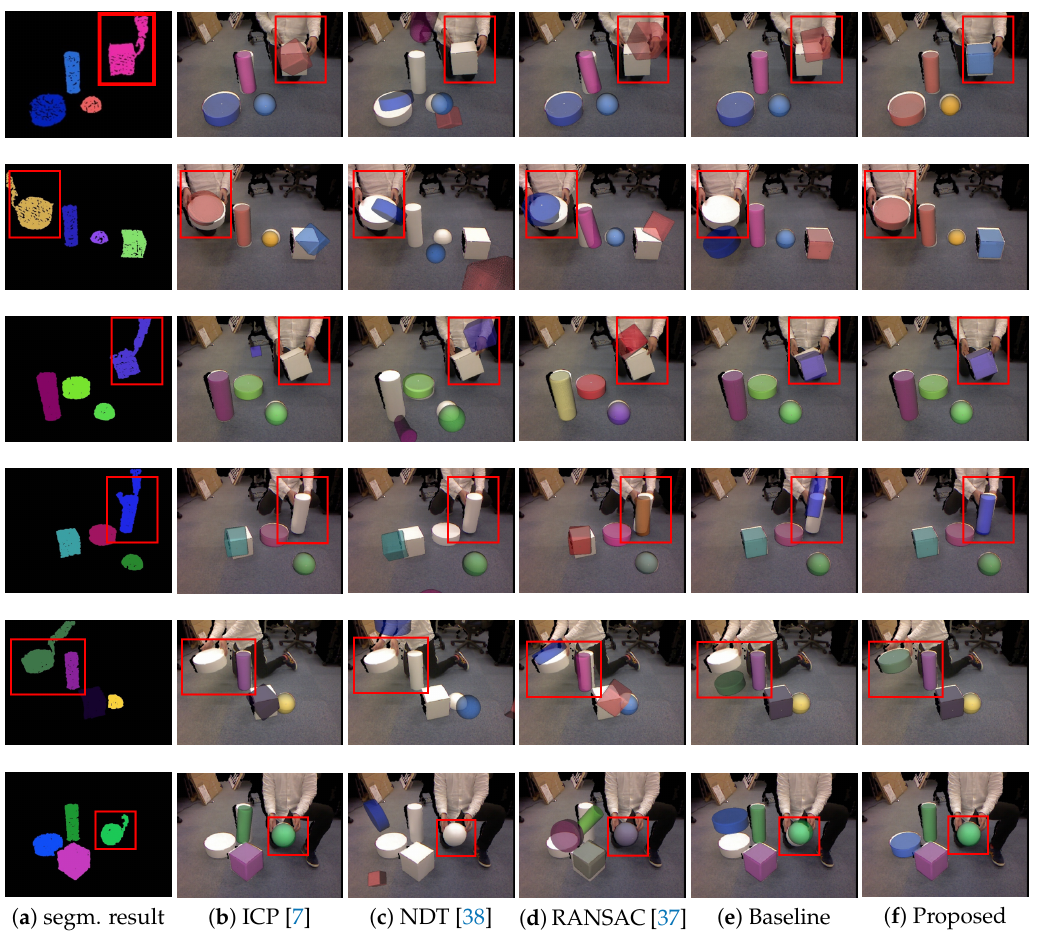
Figure 7. Comparison of the pose estimation results. ( a ) geometric segmentation result, pose estimation result by ( b ) Iterative Closest Point (ICP) tracking, ( c ) Normal Distributions Transform (NDT) algorithm, ( d ) RANSAC-based feature matching method, ( e ) the baseline method, and ( f ) the proposed method. Superquadric surfaces were rendered onto a 2D